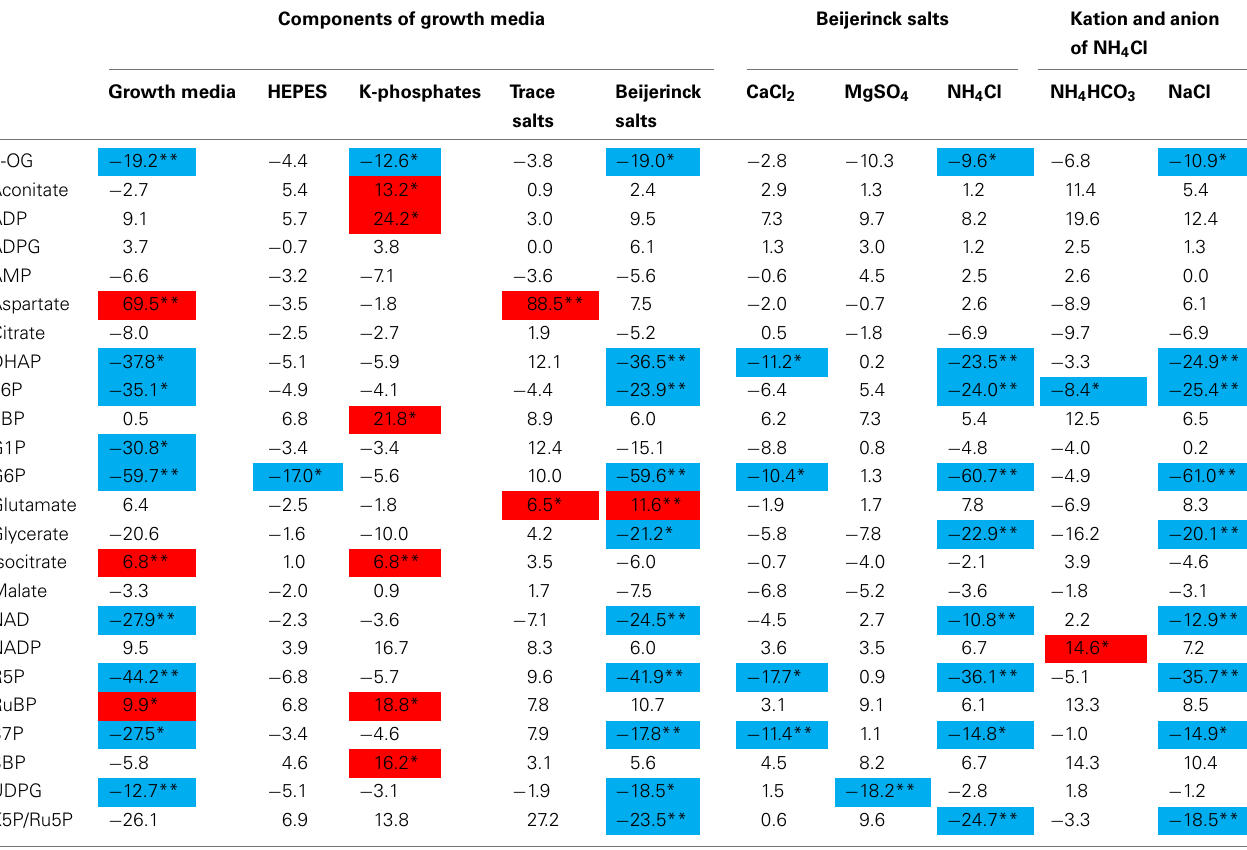
Raw data of Figure 4 . Values are expressed as % ion suppression (x < 0) or % ion enhancement (x > 0) respectively, according to the formula by Buhrman et